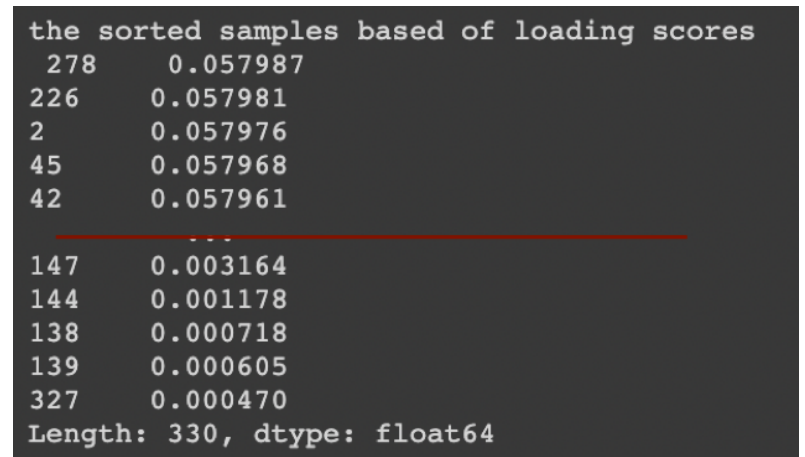
Figure 13. Threshold cutoff limit of the heart disease dataset.